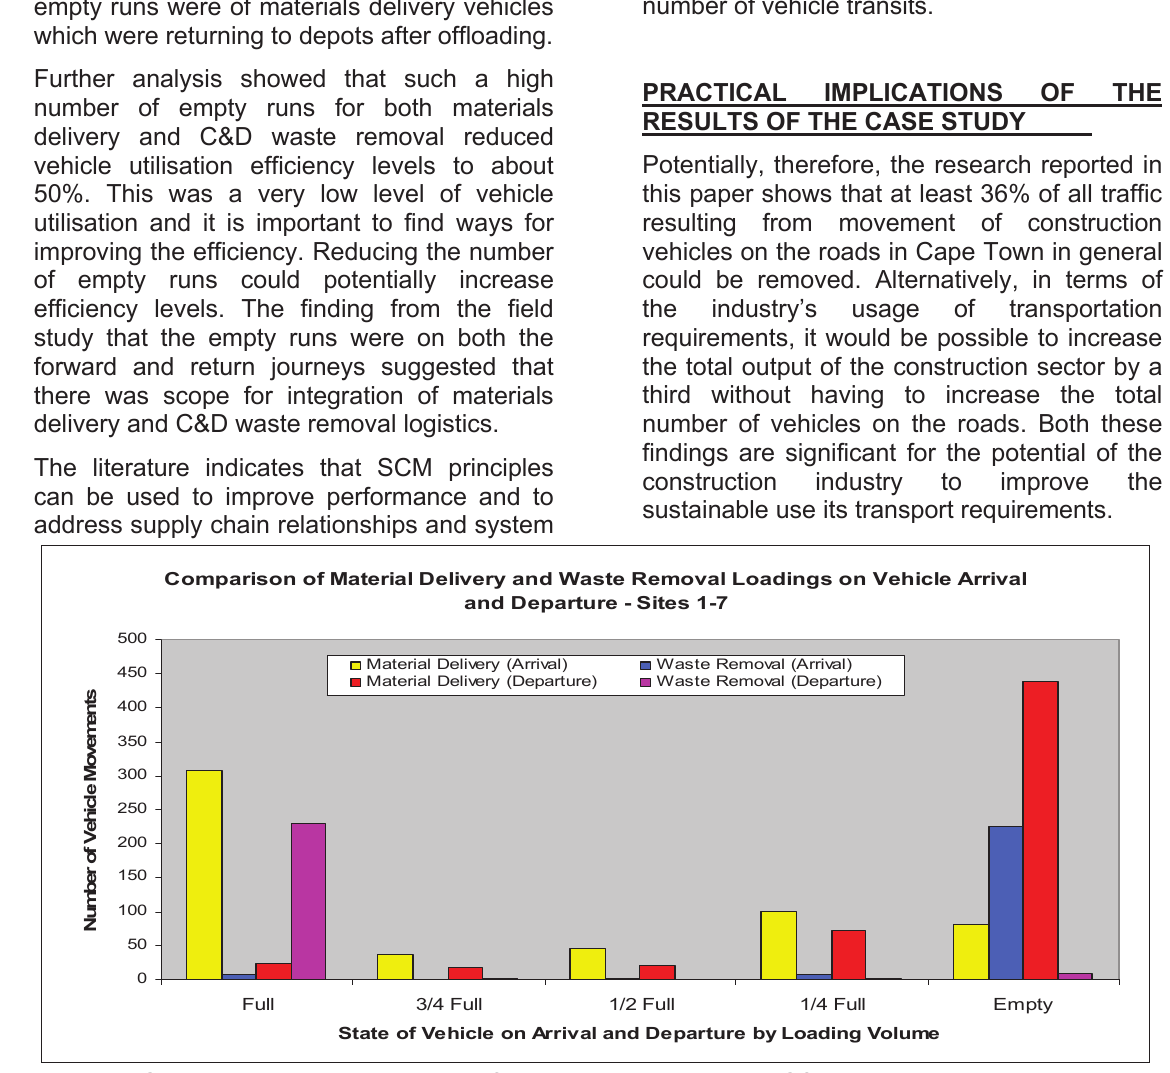
Figure 5 Comparative loading levels of materials delivery and C&D waste removal vehicles on arrival and departure at the seven